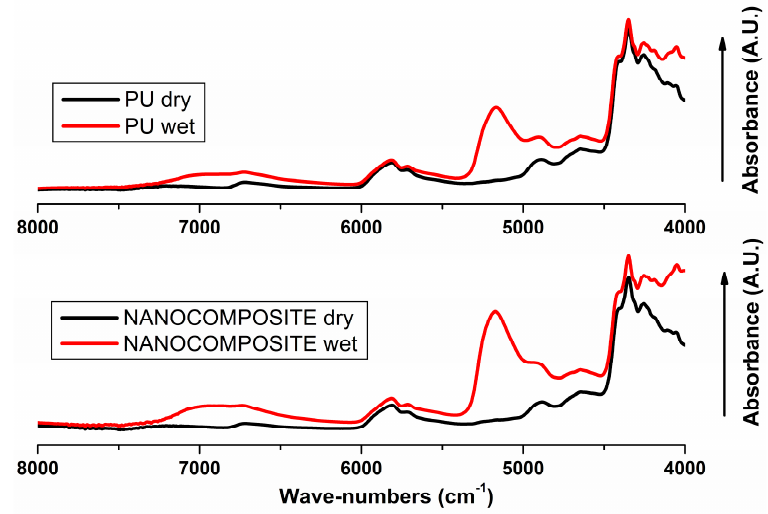
Figure 4. FT-NIR transmission spectra in the wave-number range 8000–4000 cm − 1 for dry and wet